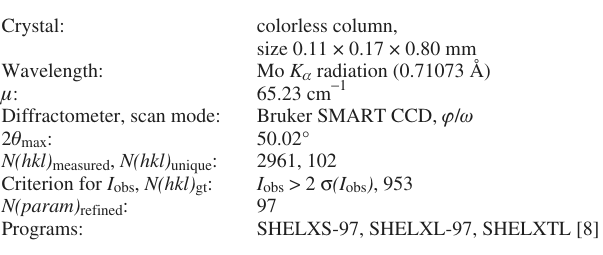
Table 1. Data collection and